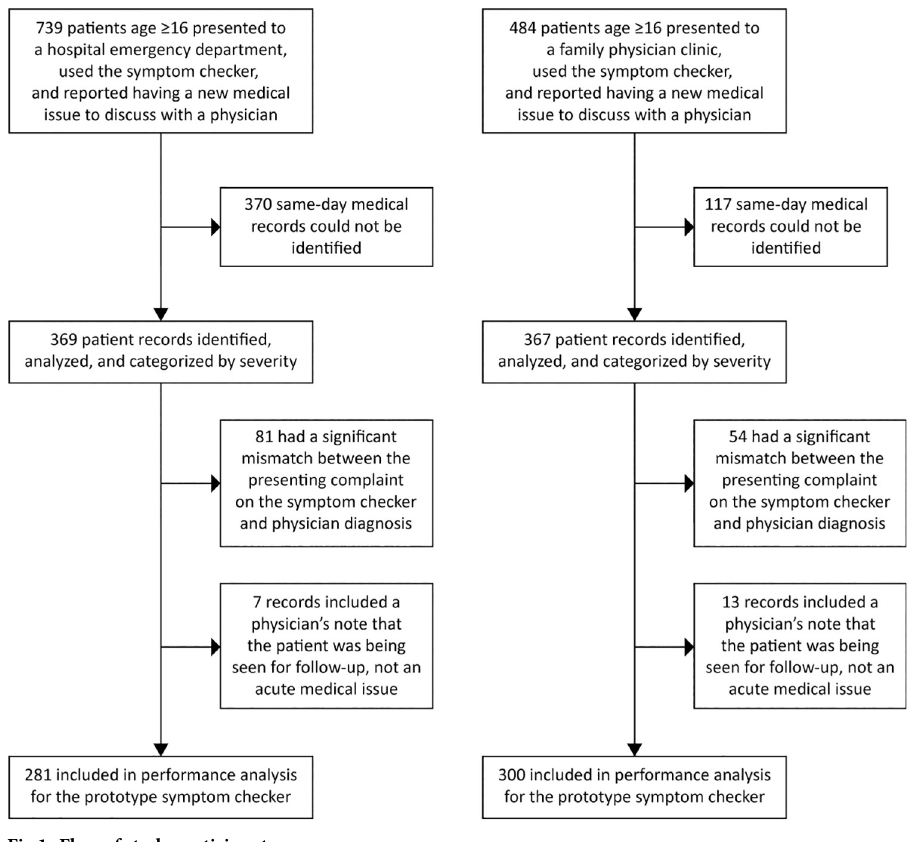
Fig 1. Flow of study participants.